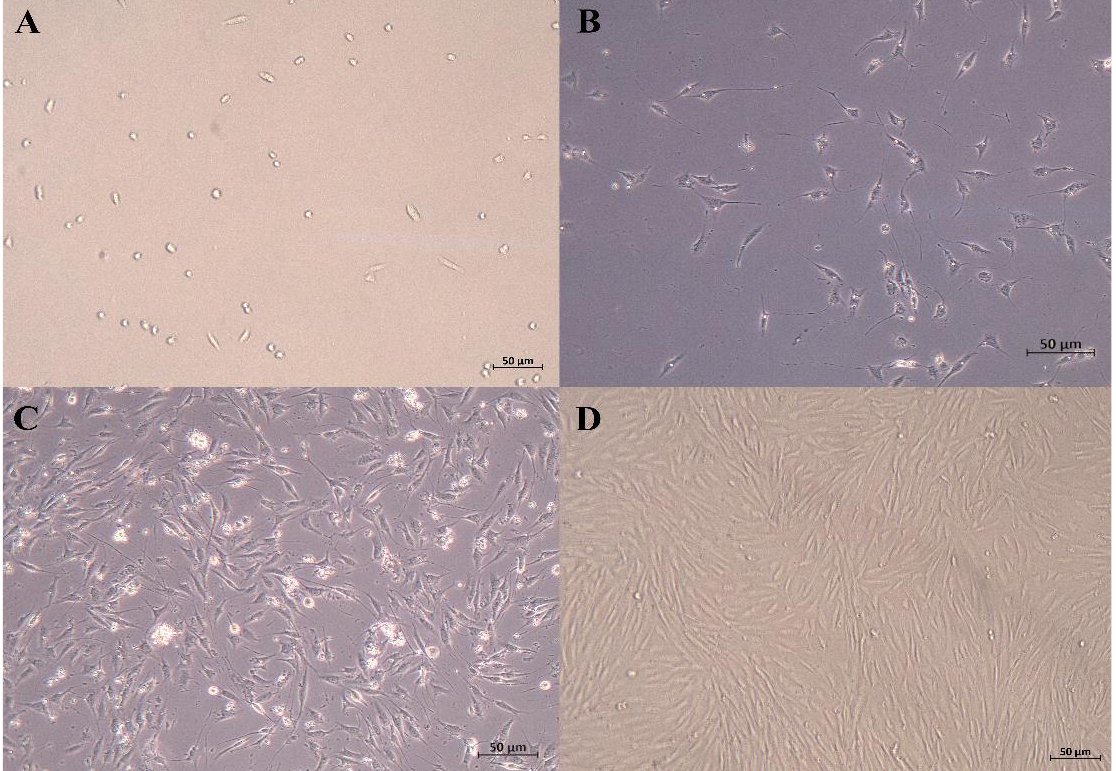
Figure 1. Micrographs of primary equine SCs. ( A ) just attached to the wall; ( B ) 24 h after isolation; ( C ) 48 h after isolation (typical SCs, with high refractive index and spindle shape); ( D ) 72 h after isolation (50 μ m).